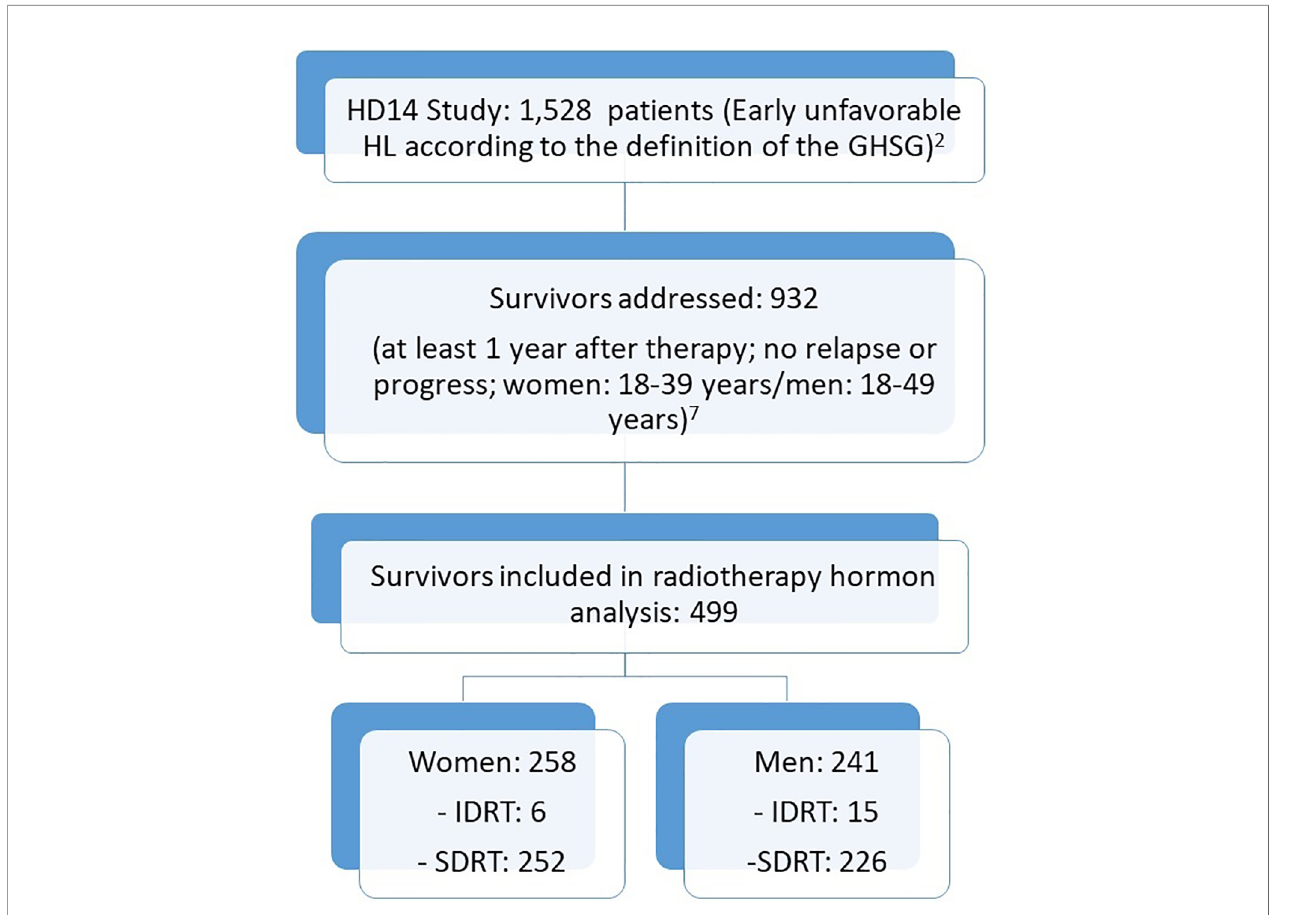
FIGURE 1 | Consort Diagram: hormone